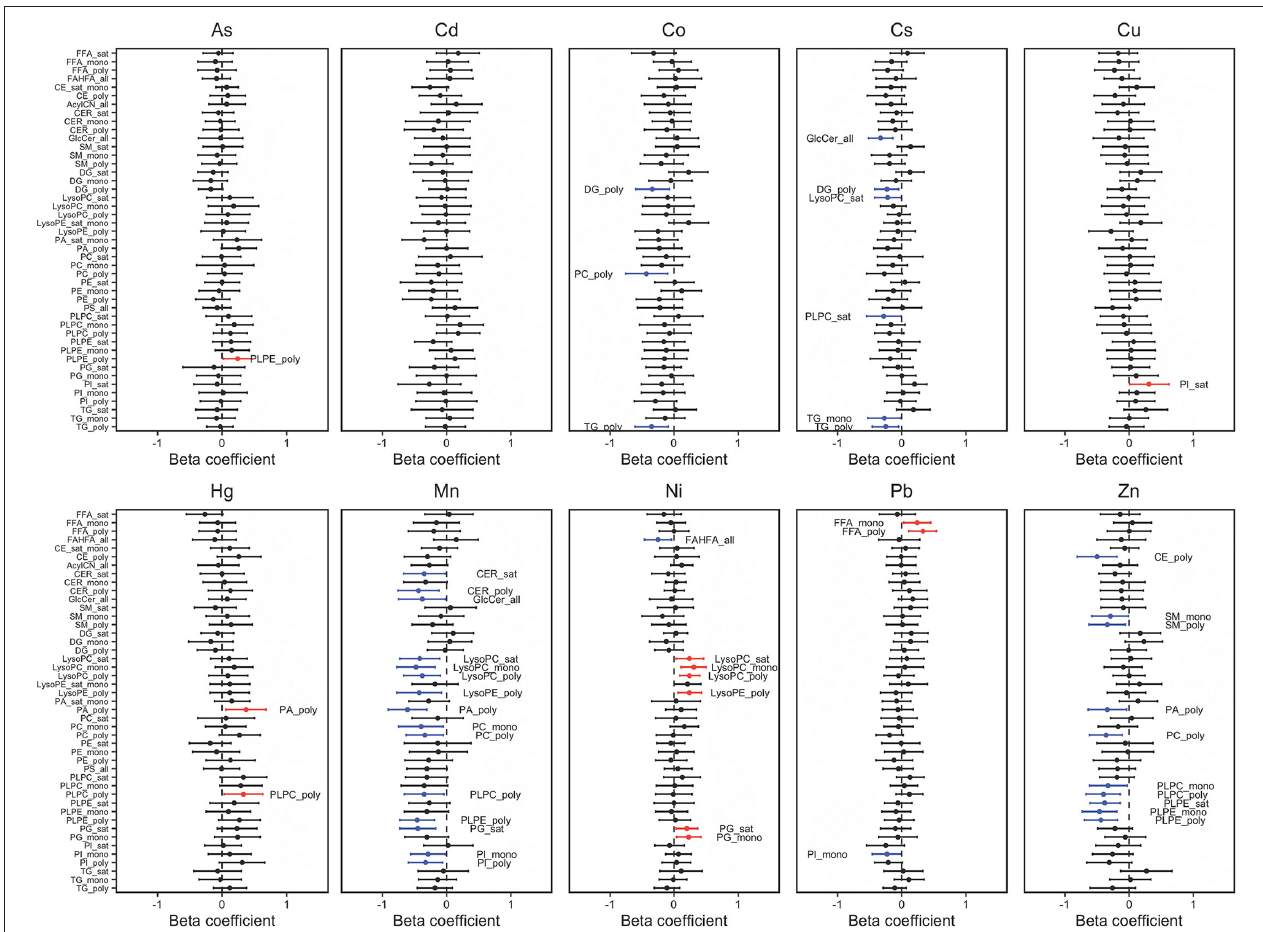
FIGURE 2 | Percent change in lipid subgroup sum z-score associated with maternal metal/metalloid blood concentrations. Effect estimates presented as percent change (%) for IQR increase in exposure biomarker concentration. Models were adjusted for maternal age, maternal education, fetal sex, pre-pregnancy BMI, weight gain during